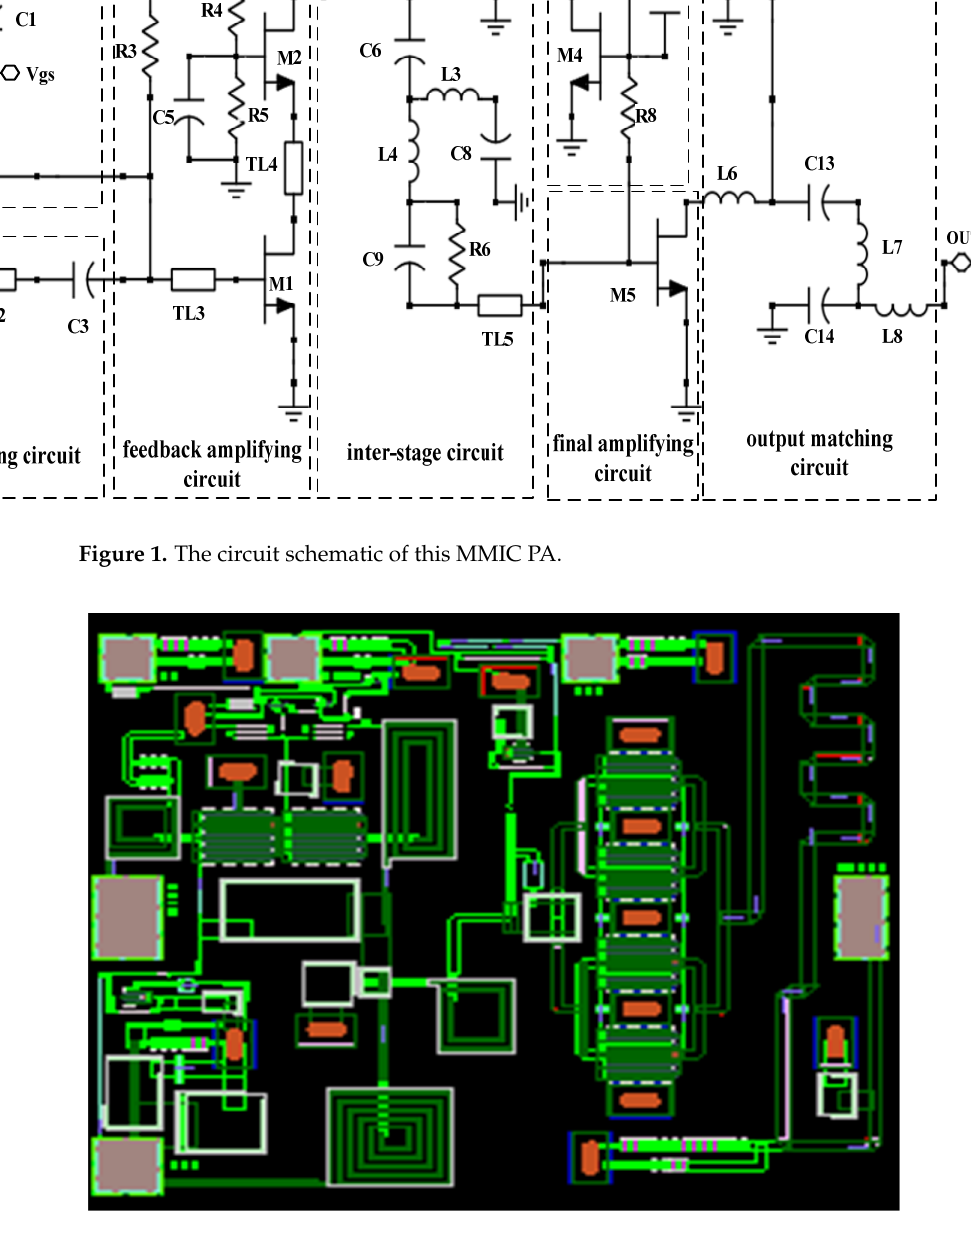
Figure 2. The layout of this MMIC